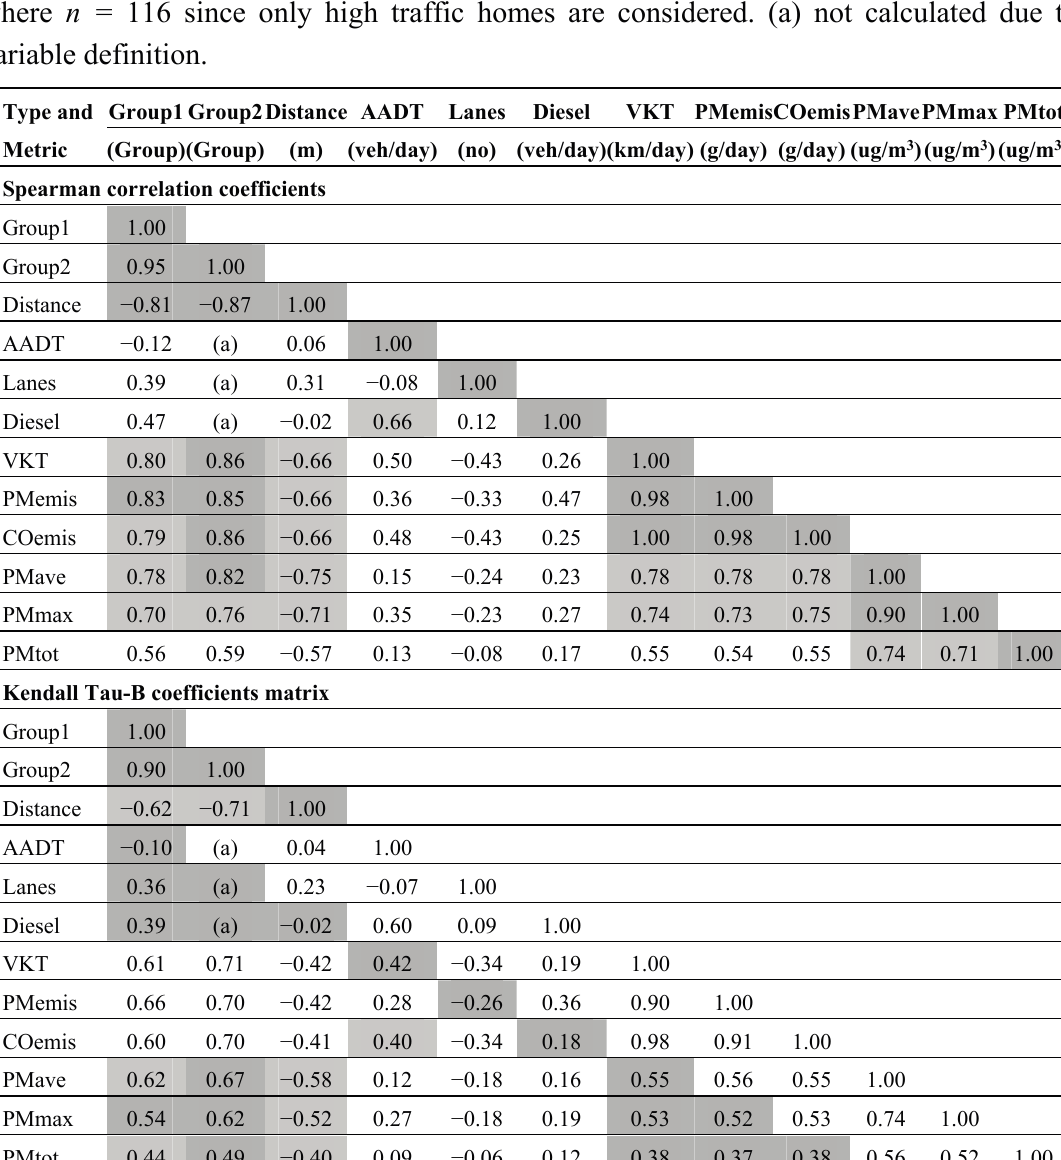
Table 3. Comparison of exposure metrics at the NEXUS homes using Spearman (top) and Kendall τ -b correlation coefficients. Shaded numbers show absolute value of correlations above 0.6 and 0.8. Variables: Group1 = LDLT, LDHT and HDHT assigned 1, 2, 3, respectively; Group2 = LDLT, LDHT and HDHT assigned 1, 2, 2, respectively; Distance = distance to nearest major highway (LDHT and HDHT only); AADT = traffic volume on nearest major road (LDHT and HDHT only); Lanes = number of lanes on nearest major road (LDHT and HDHT only); Diesel = diesel vehicles volume on nearest major road (LDHT and HDHT only); VKT = traffic density as vehicles-km-traveled/day in 300 m buffer around home; PMemis = PM 2.5 emissions in 300 m buffer; COemis = CO emissions in 300 buffer; PMave = 2010 annual average PM 2.5 concentration due to local traffic; PMmax = 2010 maximum 24-h average PM 2.5 concentration from local traffic; PMtot = 2010 annual average PM 2.5 concentration from all sources. Sample size is n = 218, except for comparisons involving AADT, Lanes, and Diesel